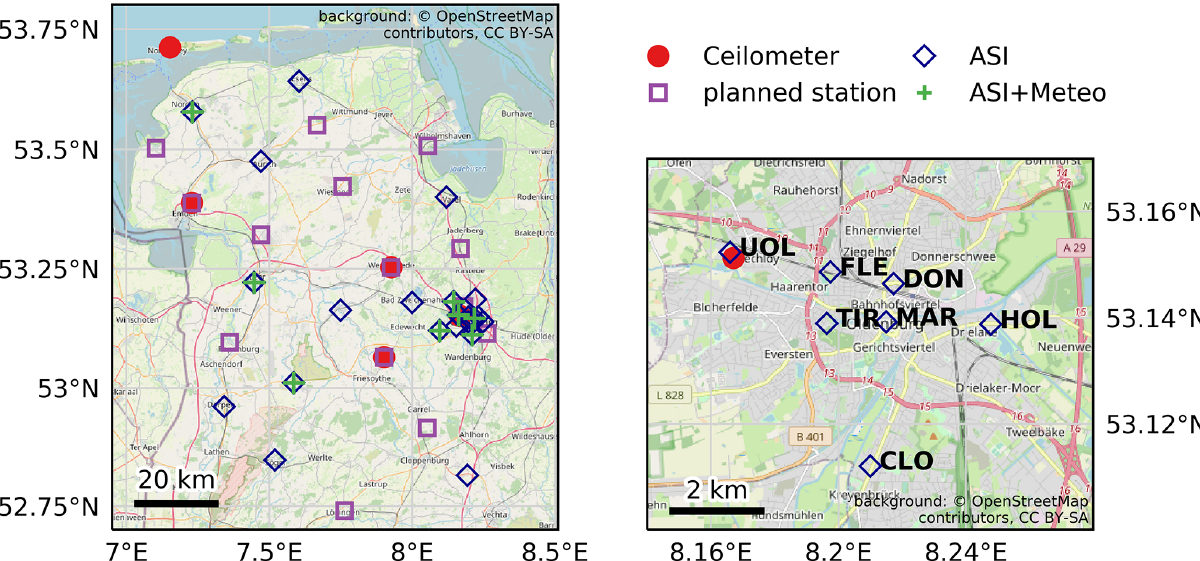
Figure 1. Overview of the Eye2Sky ASI network including operational ASIs (ASI), radiometric measurements (Meteo) and planned stations (left) and ASIs in the city of Oldenburg that have been included in this study (right). The ceilometer used as a reference (marked by a red circle in the right figure) is located near the northwestern-most ASI UOL. Background source: © OpenStreetMap contributors, 2021. Distributed under the Open Data Commons Open Database License (ODbL)